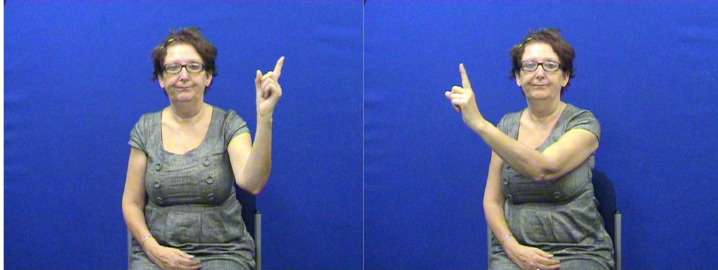
Figure 2. Whole entity construction depicting a person walking past